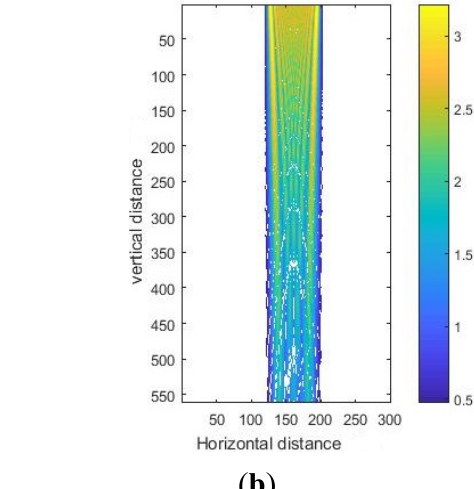
( b ) Figure 18. SEM photo of a SU-8 pillar ( a ) and simulation result ( b ) for linewidth/spacewidth of 30/30 μ m. Figure 18 shows the simulation and experimental results for linewidth/spacewidth of 30/30 μ m. Through measurement and calculation, the top and bottom widths of the photoresist cylinder, shown in Figure 18a, were found to be 32.35 and 35.29 μ m, respectively. Therefore, the top and bottom widths of developed SU-8 pillars were enlarged by 2.35 and 5.29 μ m, respectively. Figure 19 shows the simulation and experimental results for linewidth/spacewidth of 30/50 μ m. The top and bottom widths of the photoresist cylinder, shown in Figure 19a, were 31.78 and 33.08 μ m, respectively. Therefore, the top and bottom widths of developed SU-8 pillars were enlarged by 1.78 and 3.08 μ m, respectively. The width of the bottom of SU-8 glue is larger than that of the top. This is because the polymer is not very dense when the exposure dose at the bottom of SU-8 photoresist is relatively low. To compare the experimental and simulation results, the dimensions of simulation results were also